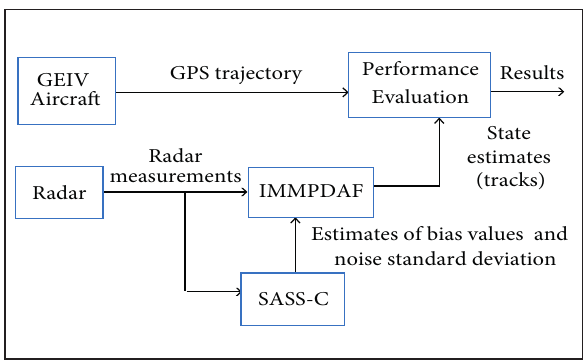
Figure 2. Performance evaluation with real data.